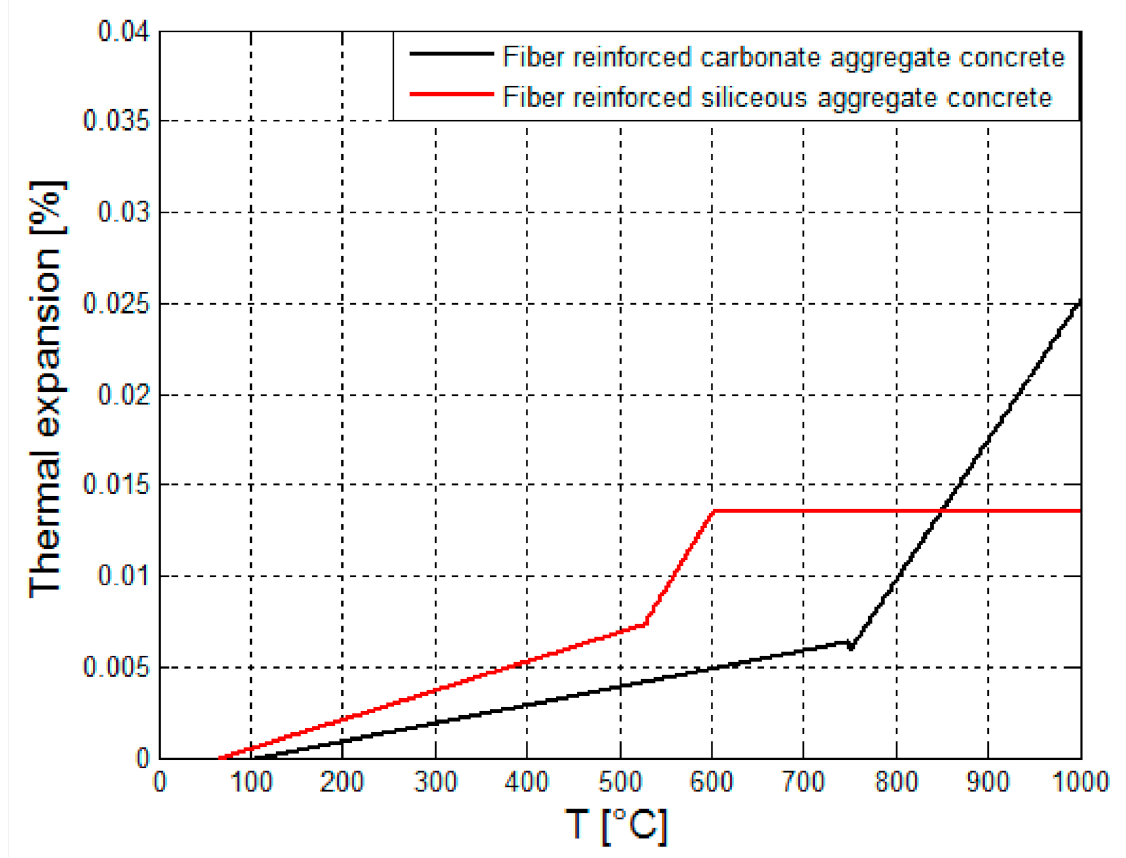
Figure 7. Coefficient of thermal expansion (CTE) curves of the different concrete types as a function of temperature